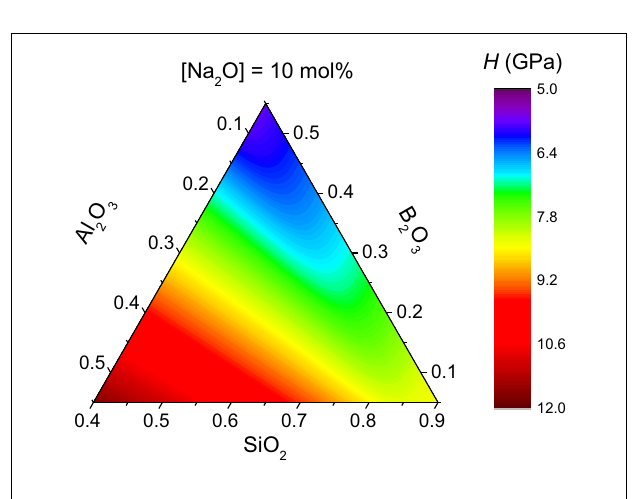
FIGURE 5 | Model calculations of hardness ( H ) for sodium boroaluminosilicate glasses that all contain 10mol% Na 2 O, i.e., the fractions in the ternary diagram represent the relative concentrations of the network-formers (SiO 2 , B 2 O 3 , andAl 2 O 3 ) . H is calculated using Eqs 1 and 2 with dH / dn = 7.3GPa. Boron and aluminum speciation have been predicted as described in the